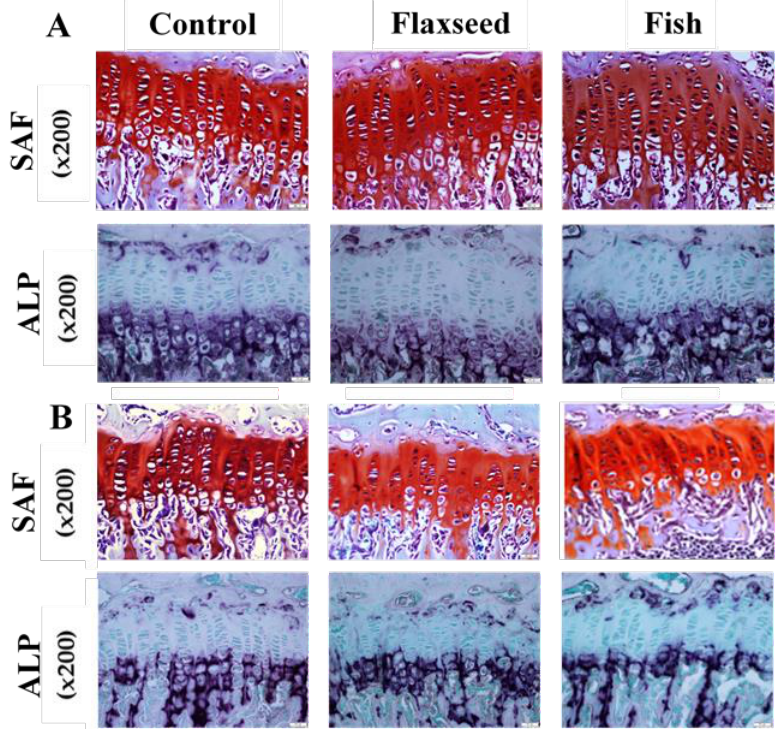
Figure 4. Histological evaluation of the tibial growth plates (GPs) of 6- and 9-week-old mice was performed for the analysis of GP morphology. Transverse tissue sections of 5 μm were prepared by microtome. ( A ) SAF-Safranin-O, and ALP-Alkaline phosphatase staining of representative tibial GPs of 6-week-old mice and ( B ) 9-week-old mice for the three different groups. Table 5. Measurement of GP width and number of cells.